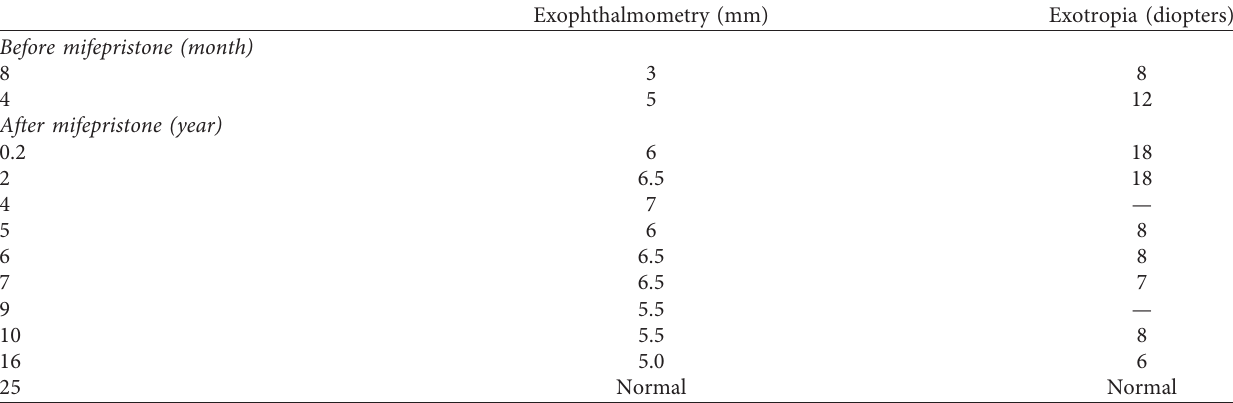
Figure 5: Magnetic resonance imaging after 23 years of mifepristone treatment. (a) Axial and (b) coronal sequences, in T1, after contrast, show significant reduction of the parasellar and dura mater expansive lesion (red arrow), with persisting thickening of the pituitary stem (purple Table 1: Evolution of right eye proptosis and left eye exotropia before and during treatment with mifepristone.